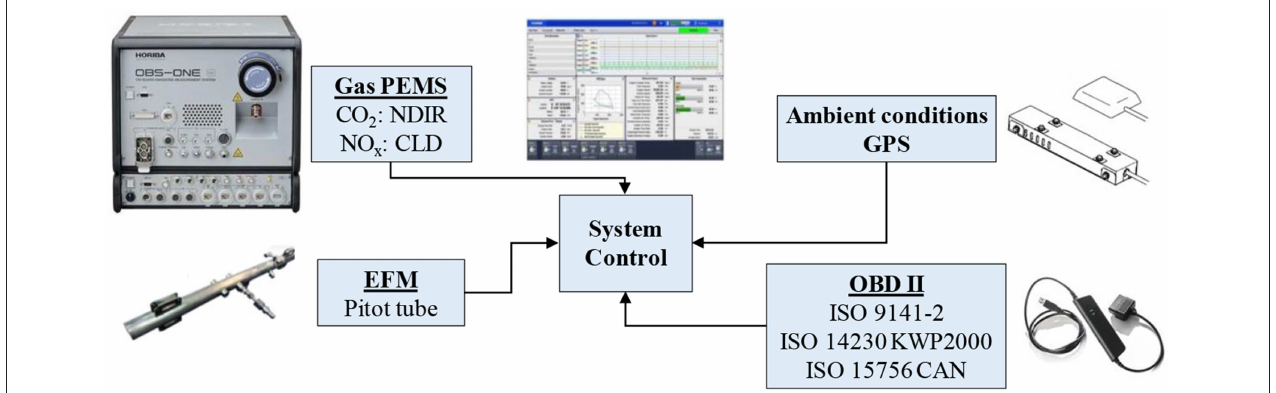
FIGURE 1 | Schematic layout of the complete test setup.